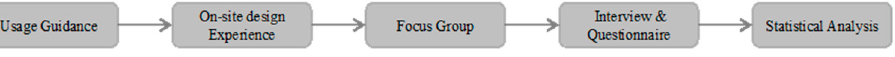
Figure 5. The on-site experimental procedures. Subsequently, each participant used the MR-DSS to engage in a ten-minute on-site design experience (Figure 6). According to the preliminary design proposal, each participant firstly selected the planned 3D street furniture models for on-site visualization in the real design scene and then made real-time design adjustments (suitable model, position, size, and materials), according to their real spatial perception and the community environmental details (Figures 7 and 8).